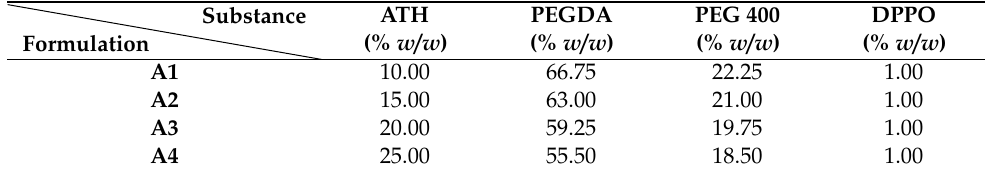
Table 1. Di ff erent photoreactive suspensions for 3D